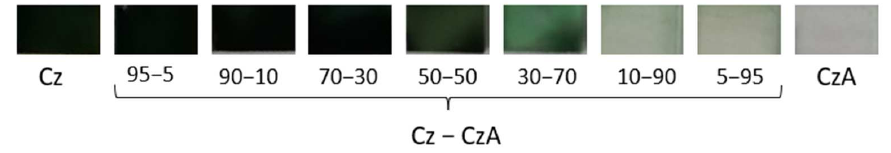
Figure 3. Pictures of polymer films obtained by electro-oxidation of Cz and CzA monomers.